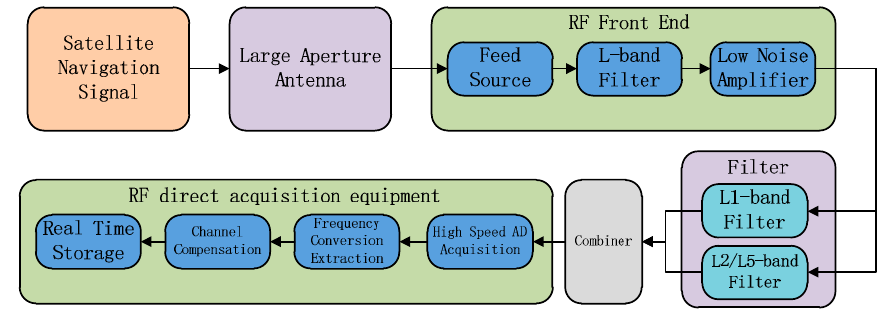
Figure 2. Low-distortion data acquisition and processing technology.